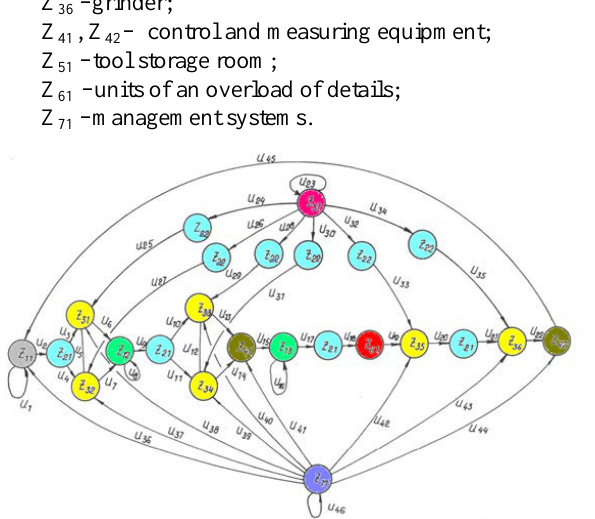
Fig. 1. Graphical interpretation of the structure of the machine tool